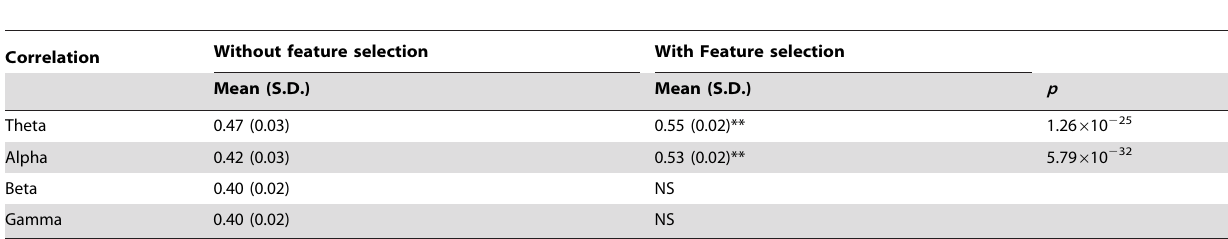
Table 4. Comparison of Classification Accuracy in Different Frequency Bands With and Without Feature Selection Base on Correlation.